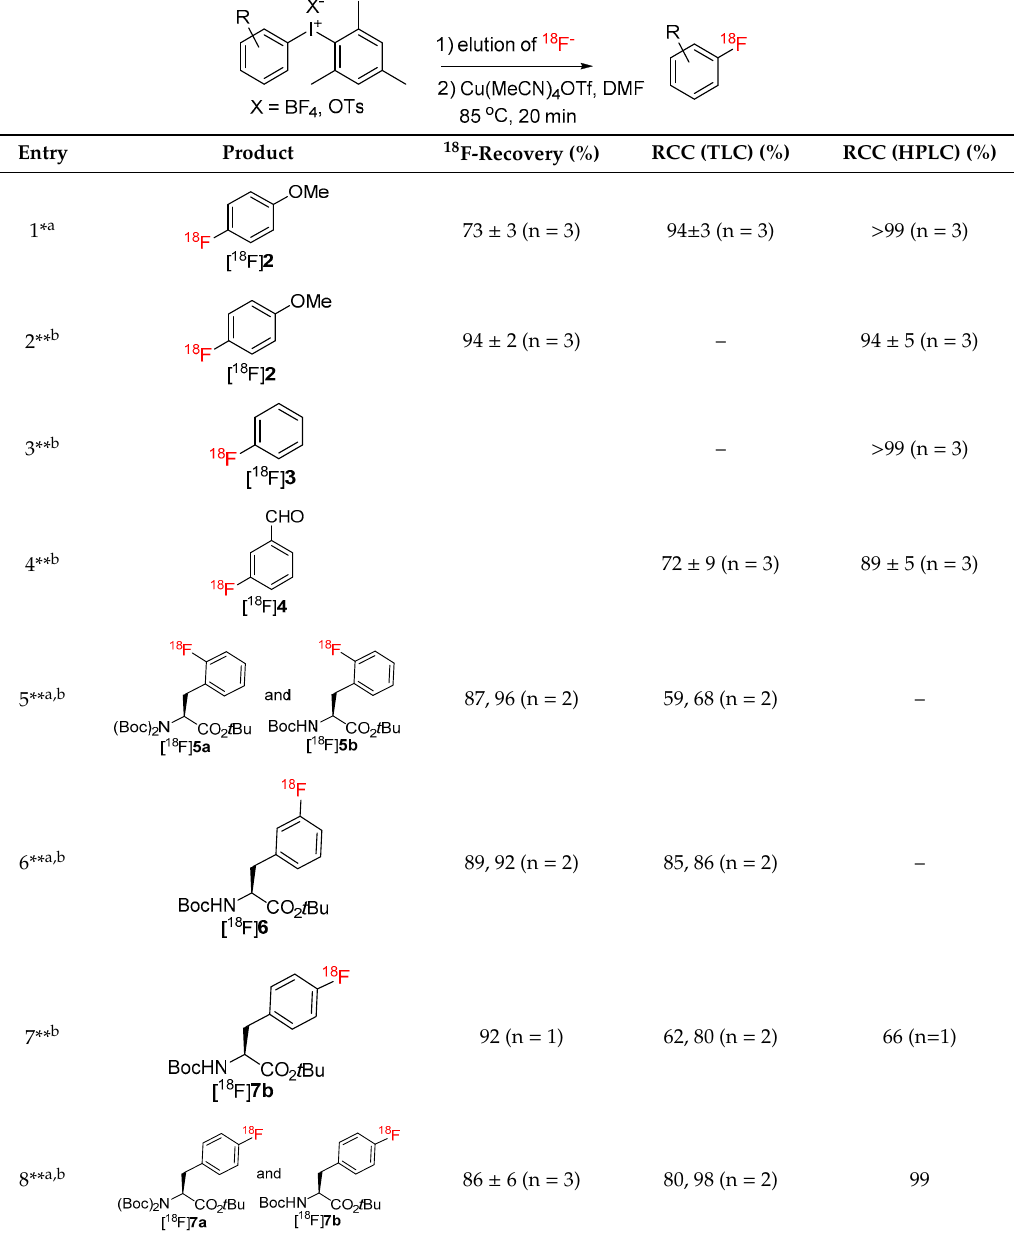
Substrate scope of (aryl)(mesityl)iodonium 1. Substrate scope of alcohol-supported Cu-mediated radiofluorination of Table1. Substratescopeofalcohol-supportedCu-mediatedradiofluorinationof(aryl)(mesityl)iodoniumsalts.